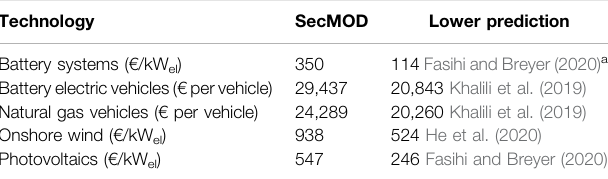
TABLE 2 | Comparison of investment costs of speci fi c technologies in SecMOD and more optimistic cost projections in 2050.